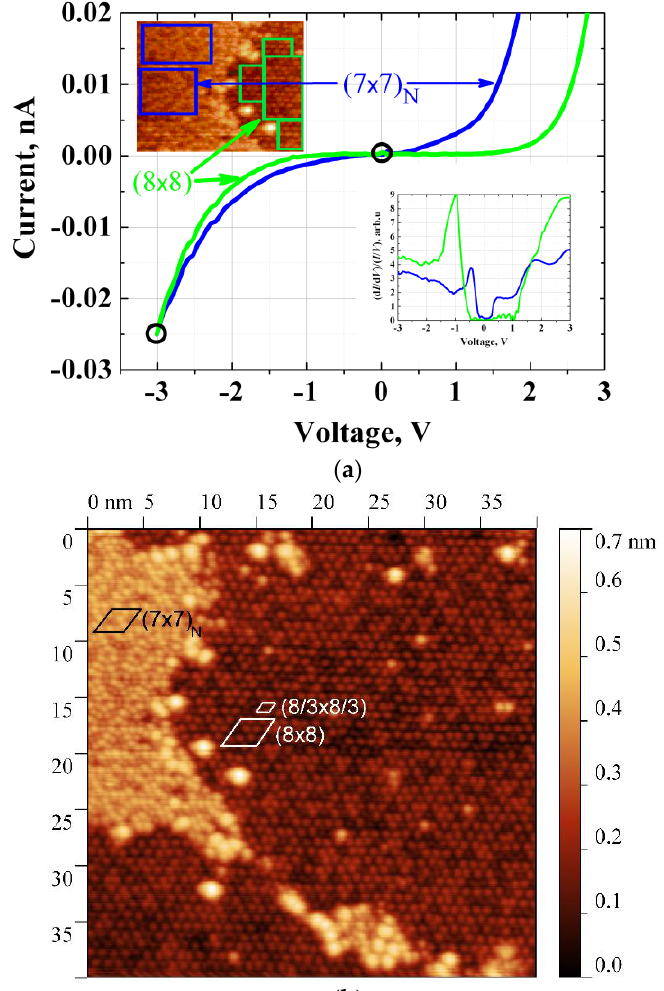
Figure 6. ( a ) I – V characteristics for the areas covered by (7 × 7) N and (8 × 8) structures, operating point −3 V , −0 .025 nA. Insets in the top-left image are the selected areas for each of the structures on which the I – V characteristics were measured; the bottom-right ones are the curves of the differential conductivity d σ n = (d I /d V )/( I / V ) obtained by the numerical differentiation of the STS. ( b ) An example of an image with coexistence of (7 × 7) N and (8 × 8) structures in high resolution (scanned at tunneling current 0.025 nA and bias −3 V) with marked (7 × 7) N , (8 × 8) and (8/3 × 8/3) unit cells. Note that both designations (8 × 8) and (8/3 × 8/3) are widely used in the relevant literature to denote the (8 × 8) structure.